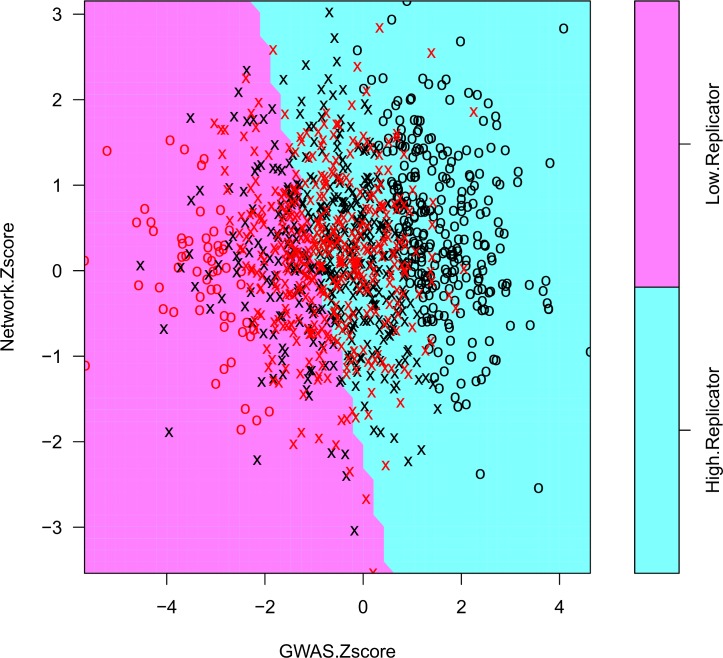
Support vector machine training to predict GWAS and network Z-score weights.Selection of genes with a high replication rate (> 0.7, blue points) and low replication rate (<0.1, red points) yielded a balanced number of genes in each replication class (high/low). A linear SVM model was trained to predict replication class using the GWAS and network Z-scores of each gene. Genes represented as X's were used as support vectors for the training of the SVM, whereas genes represented as O's were not. Both network and GWAS Z-scores contributed to the decision boundary, as demonstrated by the significance of their predicted coefficients using logistic regression (GWAS: p <2.0×10−16, Network: p = 0.0016).